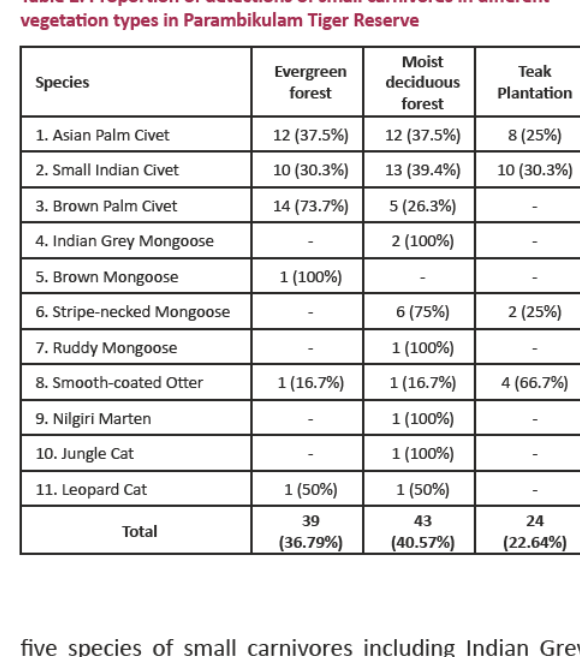
Table 2. Proporfion off detecfions off small carnfivores fin dfifferent vegetafion types fin Parambfikulam Tfiger